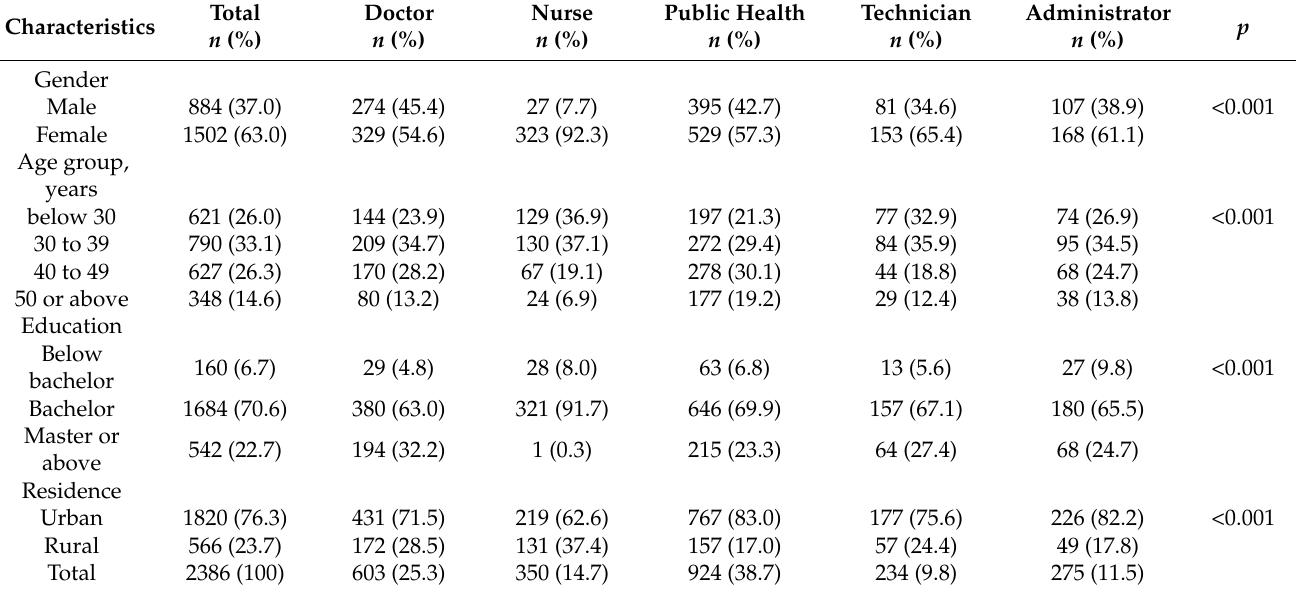
Table 1. Characteristics of different healthcare